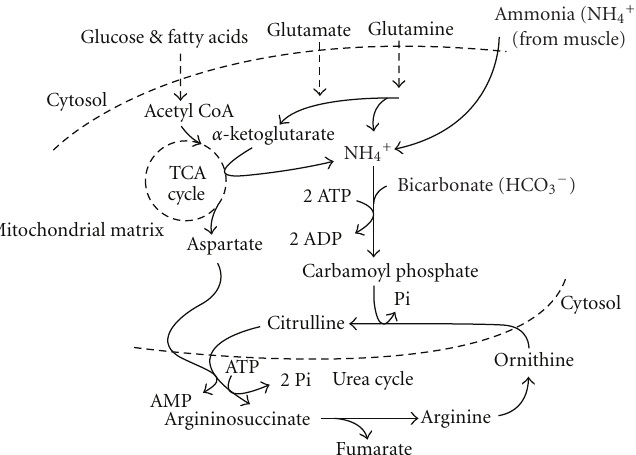
Figure 3: The urea cycle of the liver, showing the connections between the TCA cycle in the mitochondria, ammonia, and the production of urea. Note that the conversion of glutamate to α -ketoglutarate (top central region of figure) is condensed for clarity (oxaloacetate + glutamate → α -ketoglutarate + aspartate [ aspartate aminotransferase ]) and is therefore also a source of aspartate. The direct conversion of glutamate to α -ketoglutarate is catalyzed by glutamate dehydrogenase .